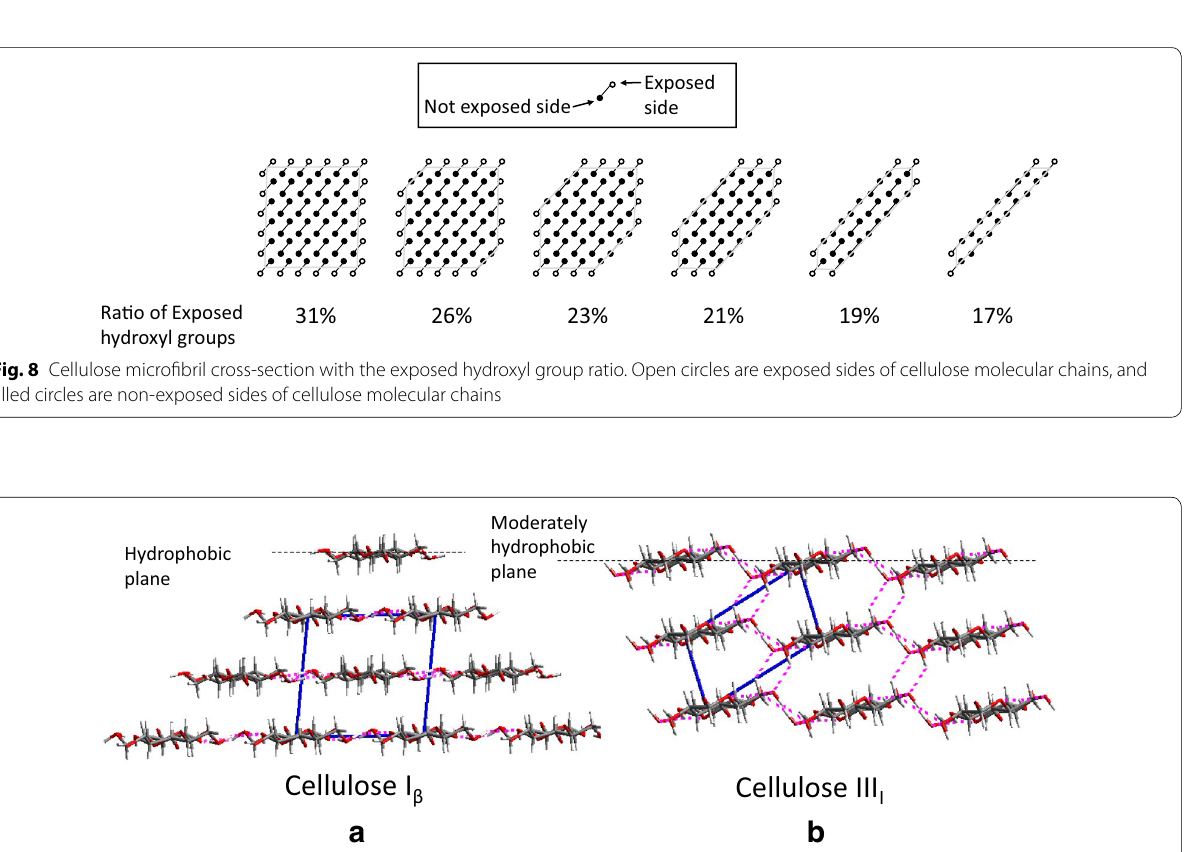
Fig. 9 Crystal structures of cellulose I β and cellulose III I (modified from The cellulose microfibril and its polymorphs [27]). a Cross-section of cellulose I β . b Cross-section of cellulose III